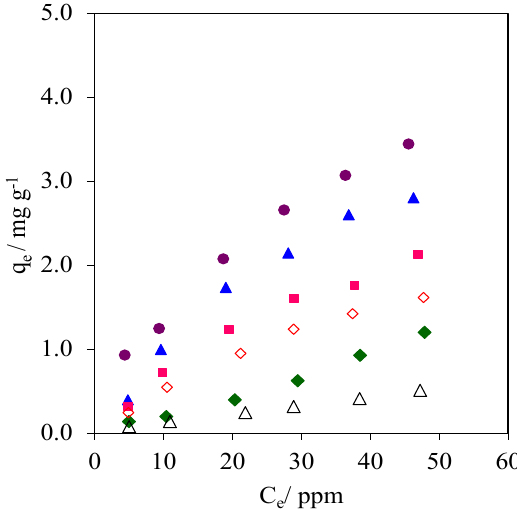
Figure 10. Isotherms of CFA adsorption onto ( Δ ) WMS, ( ◊ ) WMS-0.10, ( ⧫ ) NR/WMS, ( ● ) NR/WMS- 0.05, ( (cid:78) ) WMS-0.10 and ( (cid:4) ) NR/WMS-0.15. Table 4. Isotherm parameters of CFA adsorption onto the adsorbent.